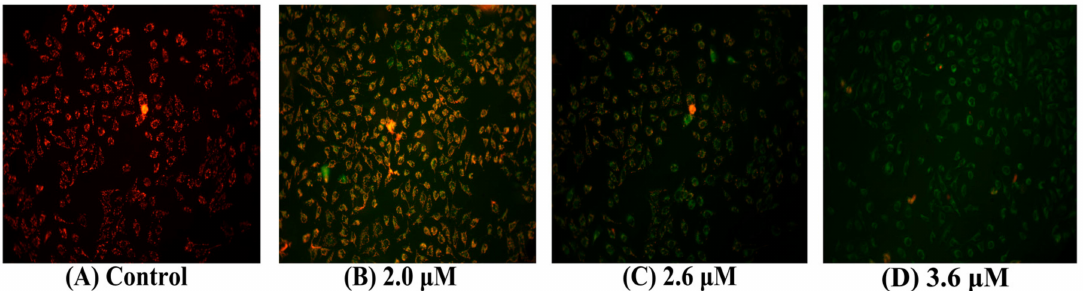
Figure 7. The loss of ∆ ψ in MGC80-3 cells treated with complex 1 (2.0, 2.6 and 3.6 µ M) for 24 h, and the cells were examined under a fluorescence microscope (Nikon Te2000, 200 × ) after being stained with